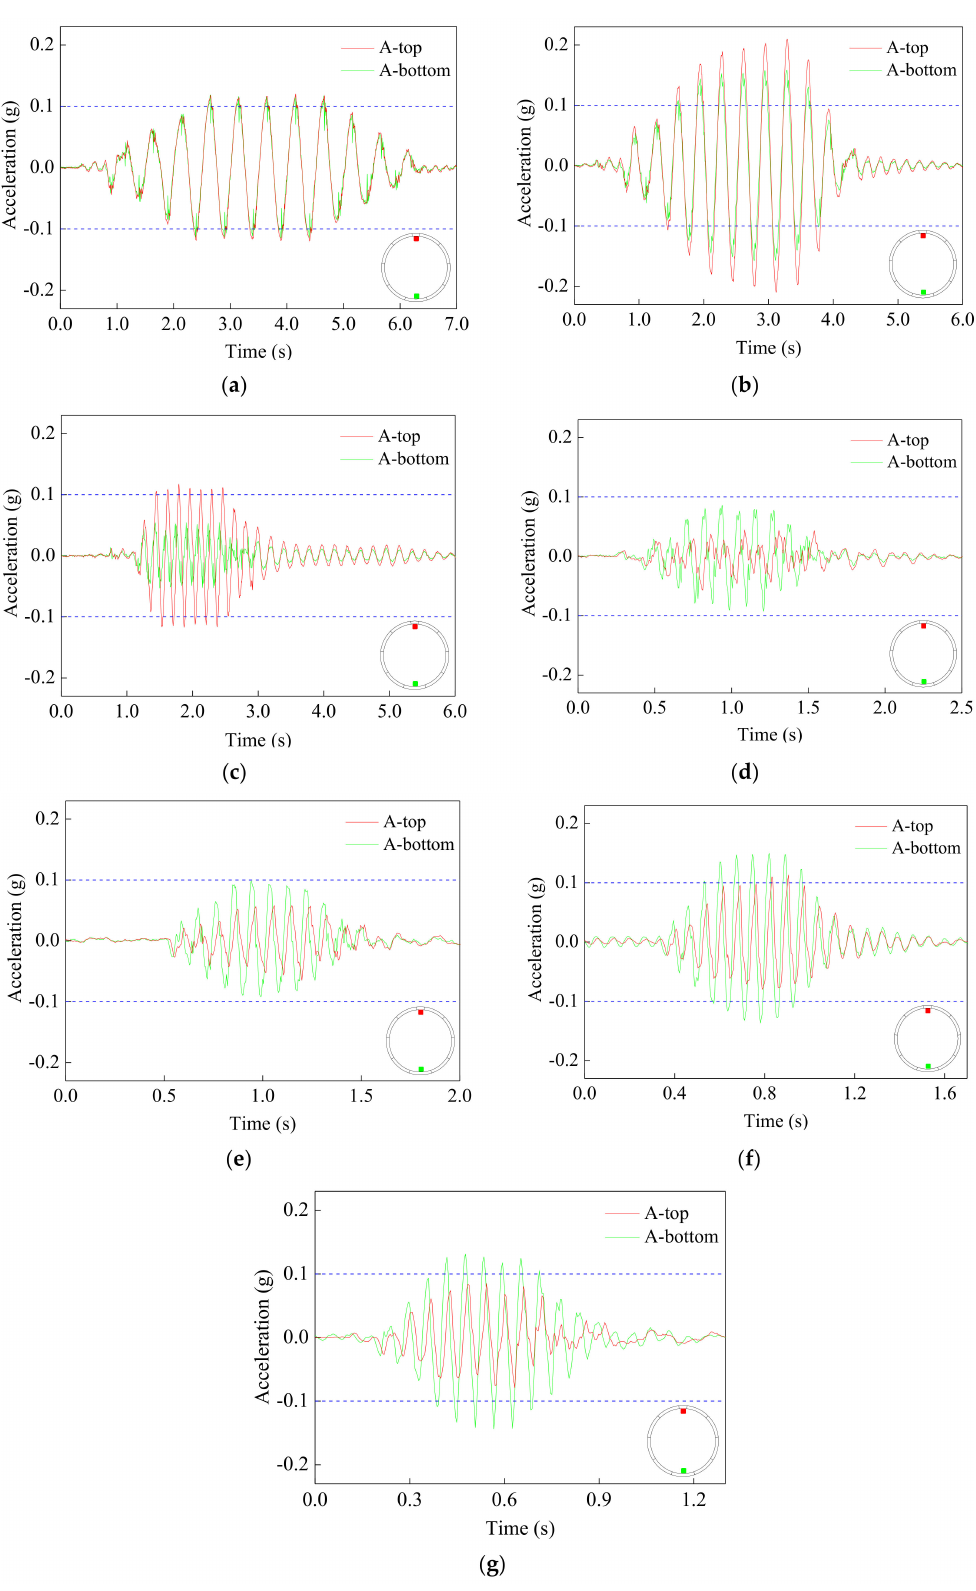
Figure 19. Acceleration responses of segmental tunnel. ( a ) Sin-2. ( b ) Sin-3. ( c ) Sin-6. ( d ) Sin-9. ( e ) Sin-11. ( f )